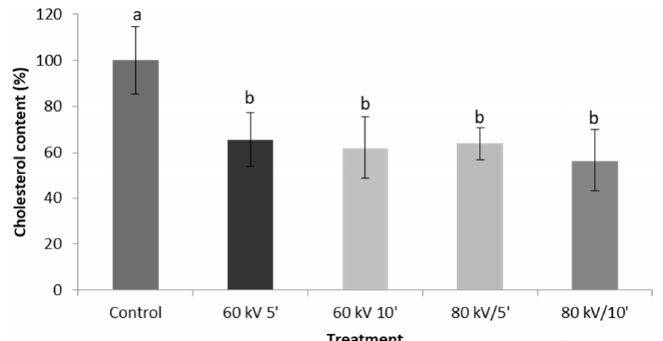
Figure 3. Cholesterol content of control and plasma-treated samples. Di ff erent letters indicate a significant di ff erence ( p < 0.05) for cholesterol at specific treatment